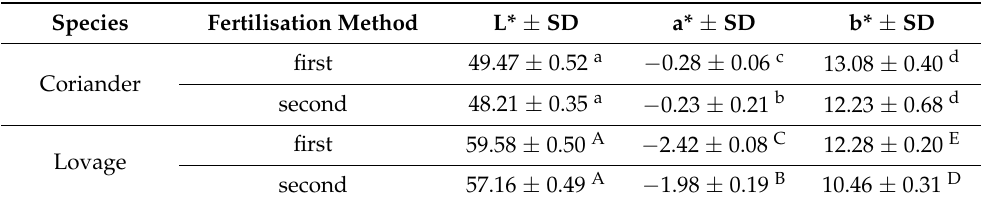
Table 1. Assessment of the colour of dry leaves of Coriandrum sativum L. and Levisticum officinale in relation to the fertilizer